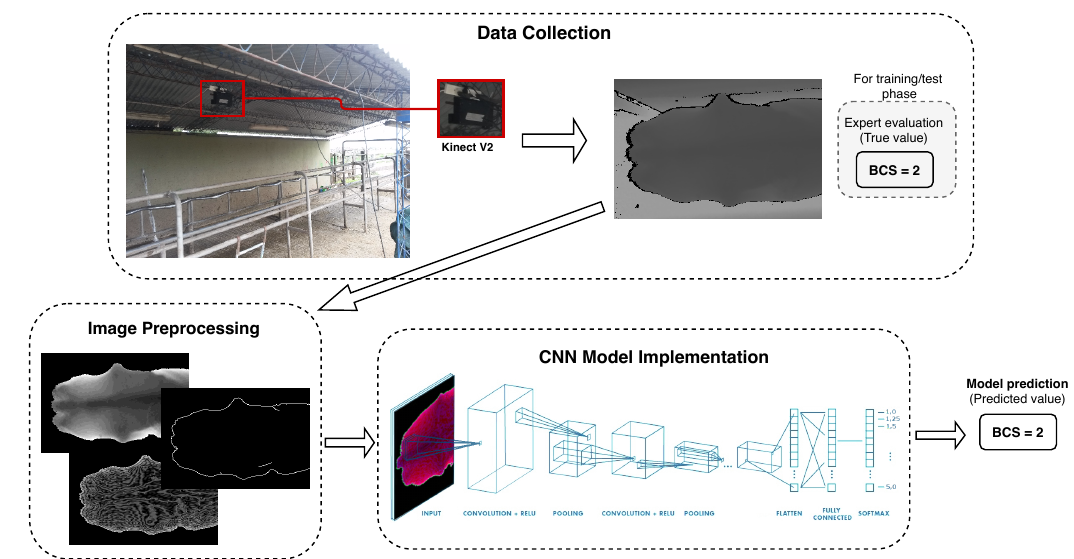
Figure 1. Overview of developed BCS estimation system